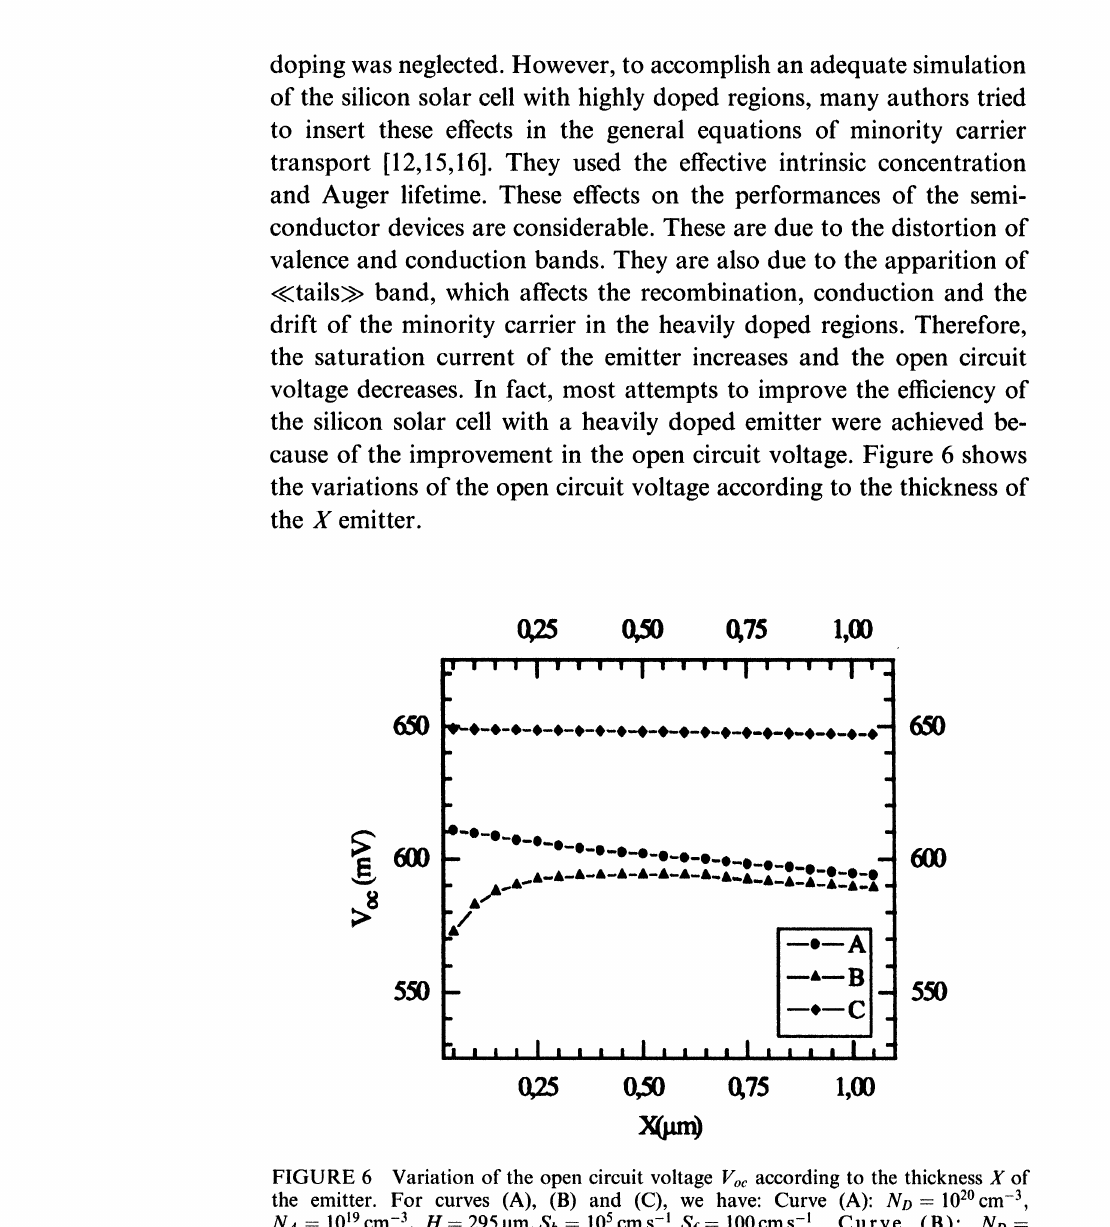
FIGURE 6 Variation of the open circuit voltage Voc according to the thickness X of the emitter. For curves (A), (B) and (C), we have: Curve (A): No--1020 cm -3, N,4 1019 cm -3, H--2951am, Sb-- 105cms -1 Sf= 100cms -1. Curve (B)’ No 102cm -3 NA 1016"5cm-3; H =2951am, Sb-- 105cms ND" 1019cm-3; NA--1017"5cm-3; H 2951am, Sb =’105cms (C):